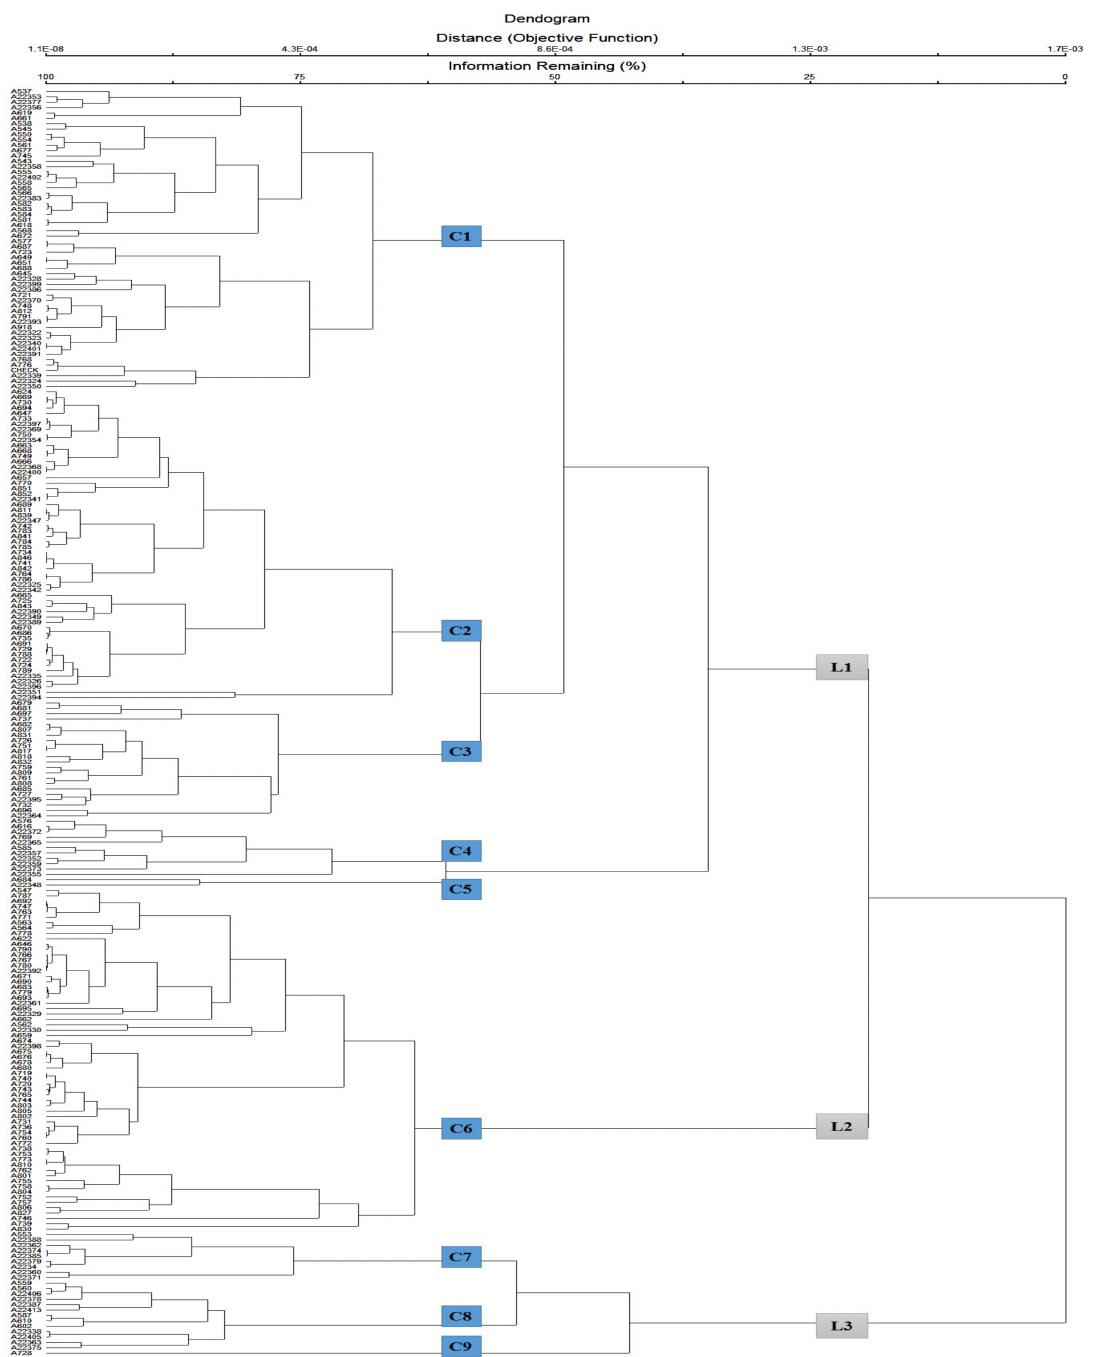
Figure 3. Cluster dendrogram of 236 genotypes of Oat ( Avena sativa ) based on 14 quantitative traits during